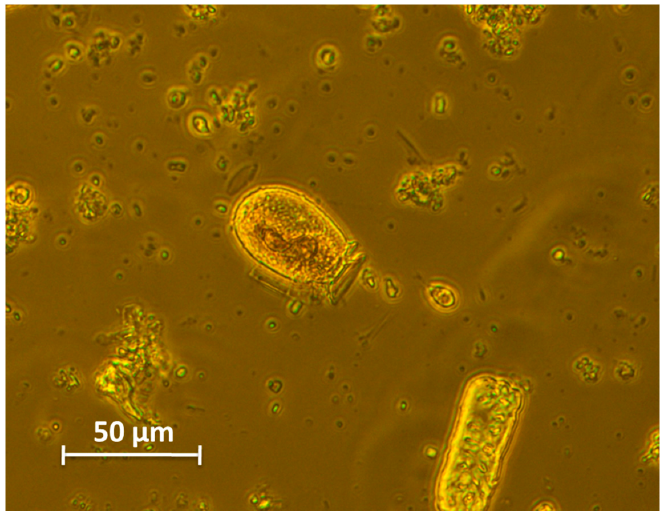
Figure 3. Optical microscope photograph of Dinophysis acuminata complex identified in Sardinia in 2021.